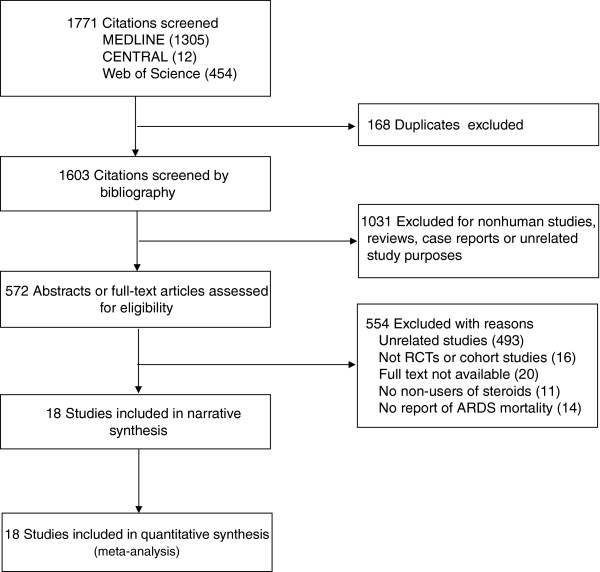
Number of studies evaluated at each stage of the systematic review.